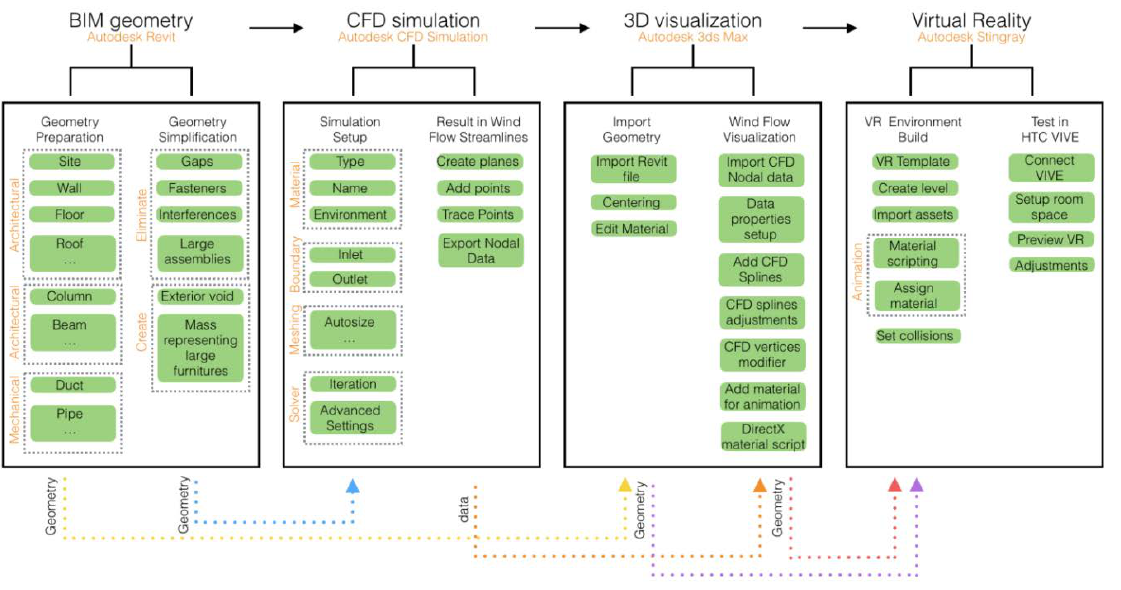
Figure 2. Proposed method of computational fluid dynamics (CFD) visualization in VR environment using BIM